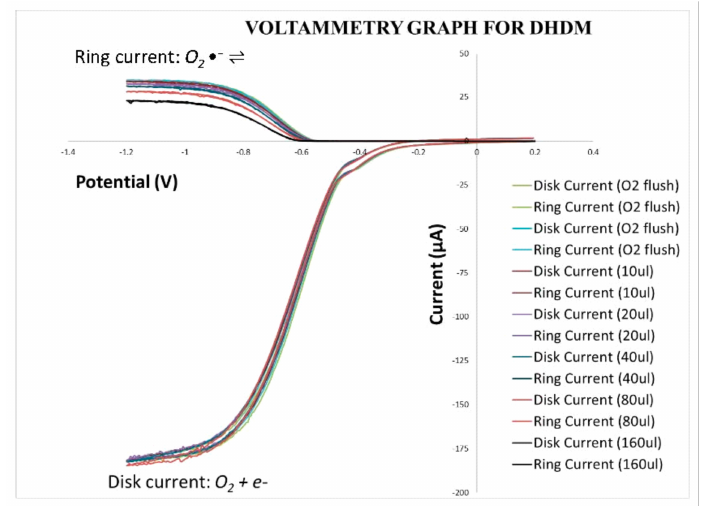
Figure 29. Effect of increasing concentrations of DHDM on current-density vs. potential curves. In Figures 29 and 30, the ring current is represented by the upper curves, while the disk current is represented by the lower curves. The generation of superoxide radicals from dioxygen occurs through a reduction reaction in the disk electrode process while the conversion of the superoxide radicals back to dioxygen (reverse reaction) occurs through oxidation in the ring electrode process. As shown by the voltammogram, this redox reaction is nearly completely reversible as, although the curves are initially separated from each other in the ring portion, the curves generated from the negative scanning of superoxide radicals overlap almost entirely with the curves generated from the positive scanning of